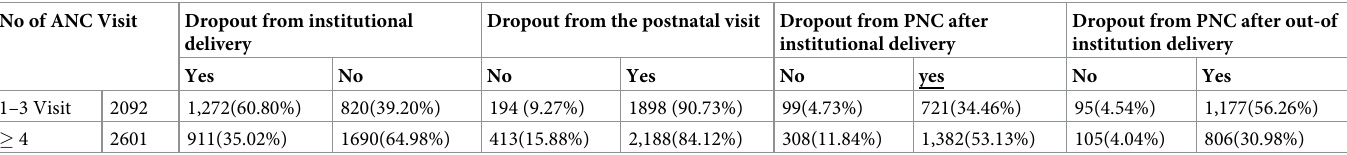
Table 2. Summary of dropout proportion from each maternity continuum of care services in Ethiopia among antenatal care booked women (N = 4,693). No of ANC Visit Dropout from institutional Dropout from the postnatal visit Dropout from PNC after delivery institutional